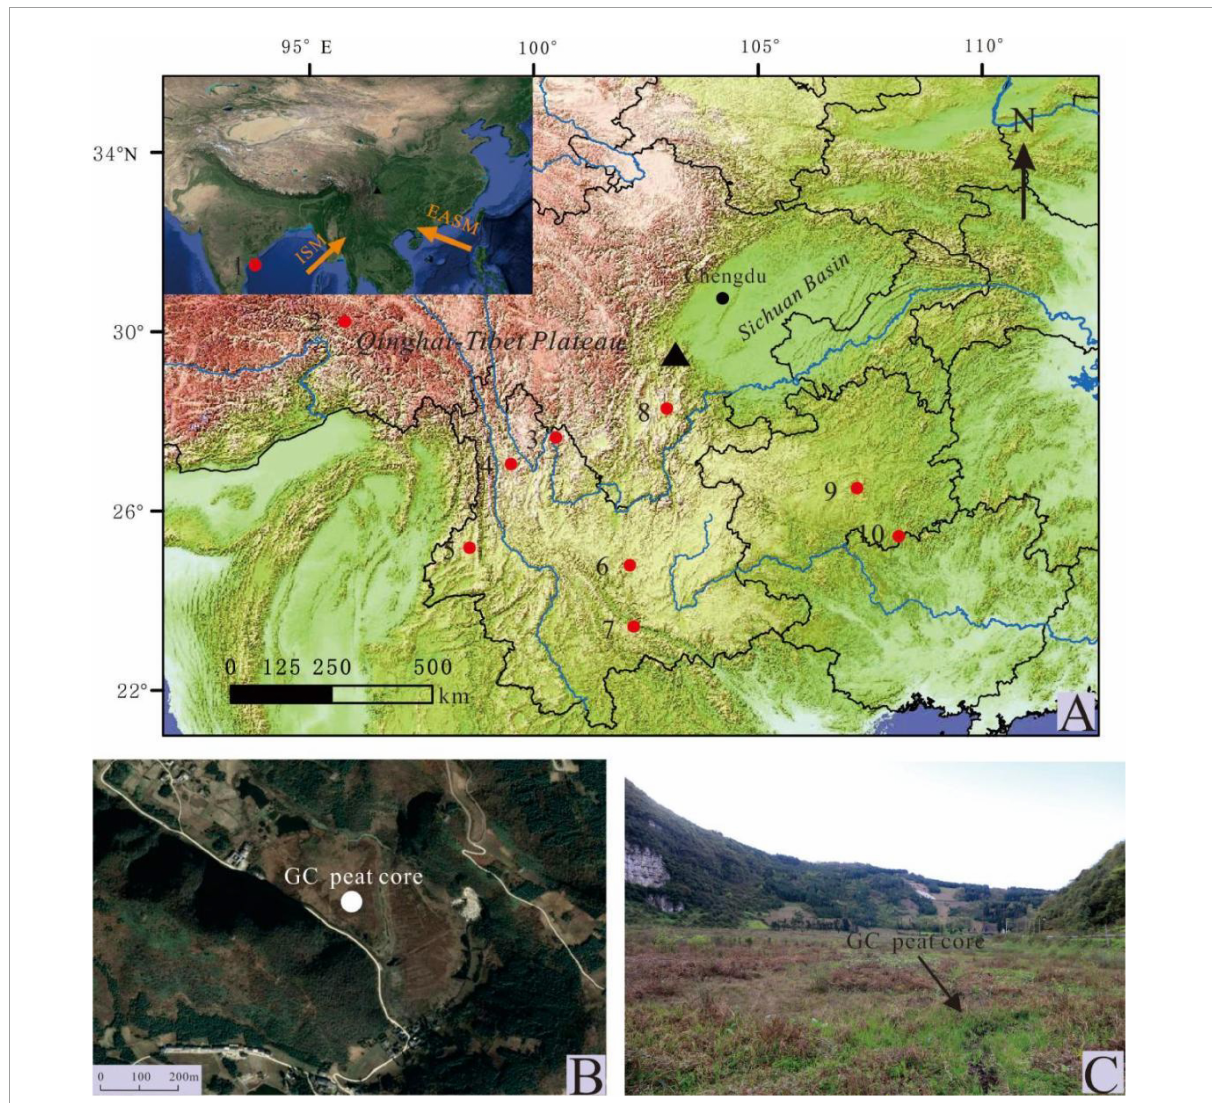
FIGURE1 Locations of the research area and the related research sites. (A) Map of the research area indicating the location of the peat site (black triangle) at the intersection between the Sichuan Basin, Yunnan-Guizhou Plateau, and QTP. The red circles indicate the location of related research sites cited in this study: (1) Core SK218 in the Indian Ocean (Govil and Divakar Naidu, 2011); (2) core NC08/01 in Nam Co Lake on the QTP (Zhu et al., 2015); (3) core LG08 in Lugu Lake, Yunnan Province (Zhang et al., 2018); (4) core TCYL1 in Tiancai Lake, Yunnan Province (Xiao et al., 2014b); (5) core TCK1 in Qinghai Lake, Tengchong County, Yunnan Province (Xiao et al., 2015); (6) core XY08A in Xingyun Lake, Yunnan Province (Wu et al., 2015); (7) core from Yilong Lake, Yunnan Province (Li et al., 2018); (8) Baoan peat core in Sichuan Province (Hong et al., 2018); (9) peat borehole NT03 in Caohai, Guizhou Province (Gong et al., 2019); and (10) stalagmites in Dongge Cave, Guizhou Province (Dykoski et al., 2005). (B) Aerial photo of the Ganchi wetland with the location of the GC core shown as a solid white circle; and (C) a physical picture shows the geomorphic environment around the sampling